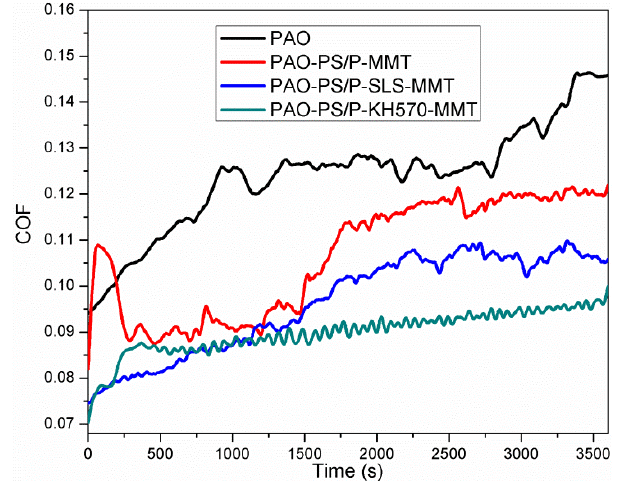
Figure 11. The COF versus time of PAO, PAO-PS / P-MMT, PAO-PS / P-SLS-MMT, and PAO-PS / P-KH570-MMT. 418